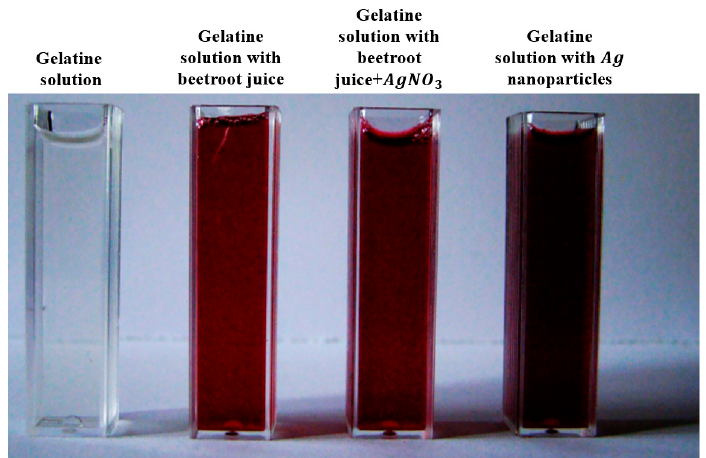
Figure 2. A photograph of cuvettes with corresponding solutions. From L to R, gelatin–water solu- tion, beetroot–gelatin–water solution, beetroot–gelatin–silver nitrate solution before UV exposure, and beetroot–gelatin–silver nitrate solution after UV exposure. Since gelatin–water solution was colorless, it could be seen that the color of beetroot– gelatin solution changed from purple red (contribution of betacyanins present in beetroot) [21–23] to bright red after adding a certain amount of AgNO (cid:2871) to the previous solution. Color transformation to brownish red after UV exposure of the beetroot–gelatin – AgNO (cid:2871) mixture indicated formation of colloid with the presence of Ag nanoparticles. Sample color was sensitive to the amount of AgNO (cid:2871) added to the mixture and to UV irradiation.